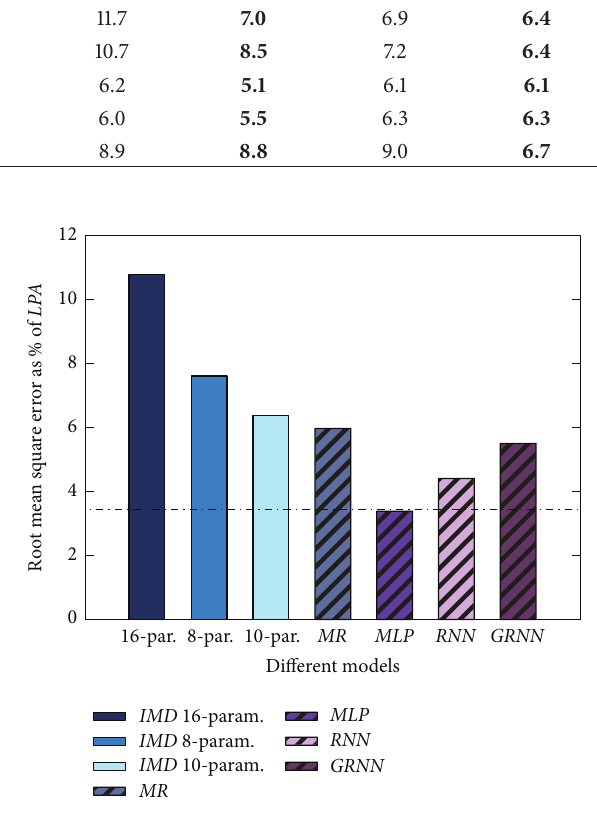
Figure 7: Comparison of MR (grey), MLP (purple), RNN (light purple), and GRNN (deep purple) models with IMD existing 16- param. (deep blue), 10-param. (blue), and 8-param. (light blue) models for time period of 1996–2002 [4, 5]. Striped bars represent errors by our proposed